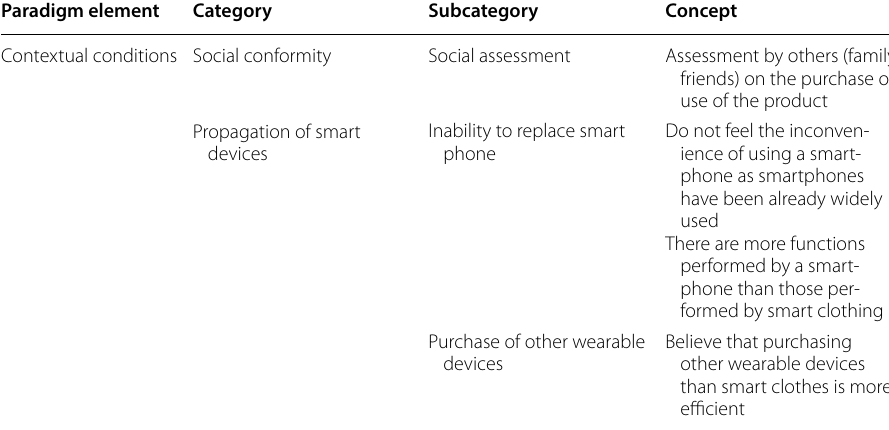
Table 4 Categories, subcategories, and concepts of contextual conditions Paradigm element